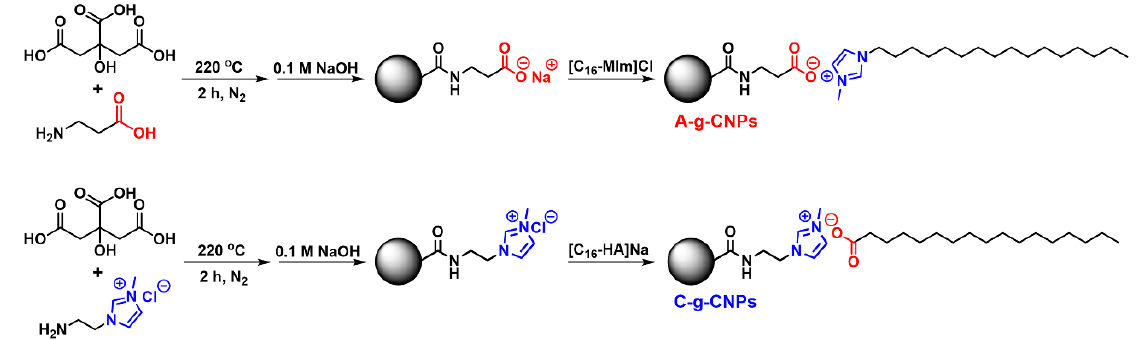
Fig. 1 Outlines of synthetic processes of A-g-CNPs and